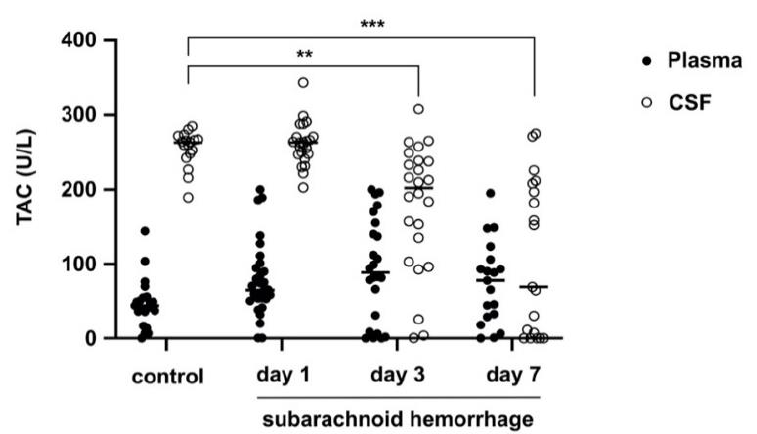
Figure 2. Total antioxidant capacity (TAC) in plasma and CSF from patients with SAH and controls. Mean plasma levels of TAC at day 1 were not statistically different compared to controls. TAC levels in CSF declined from day 1 to 7 after SAH becoming significantly different from controls at days 3 and 7 ( p < 0.0001). **: p < 0.01; ***: p < 0.001. Correlation of TAC, SOD, and GSH/GSH-Px with clinical outcome: Decreased SOD levels in plasma and CSF are associated with a worse neurological outcome 6 weeks (mRS: CSF p = 0.0001; plasma p = 0.027/GOSE: CSF p = 0.001; plasma p = 0.001) and 6 months